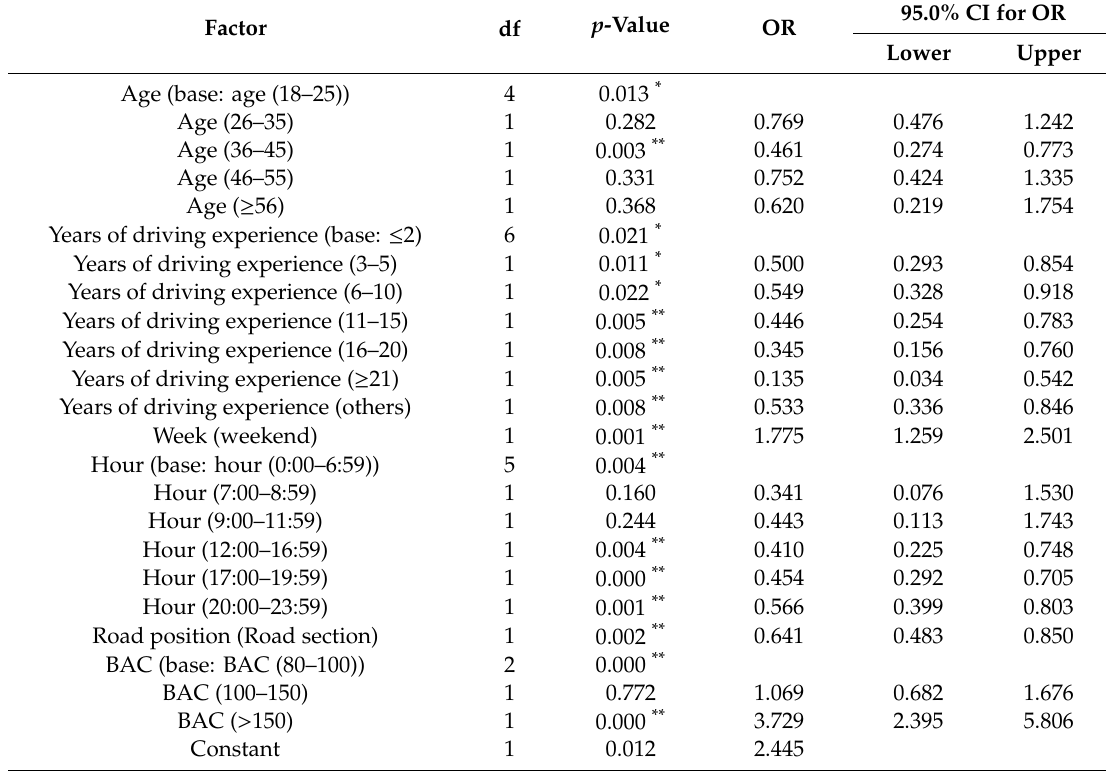
Table 2. Significant factors associated with intoxicated driving-related crashes in Wujiang. Factor